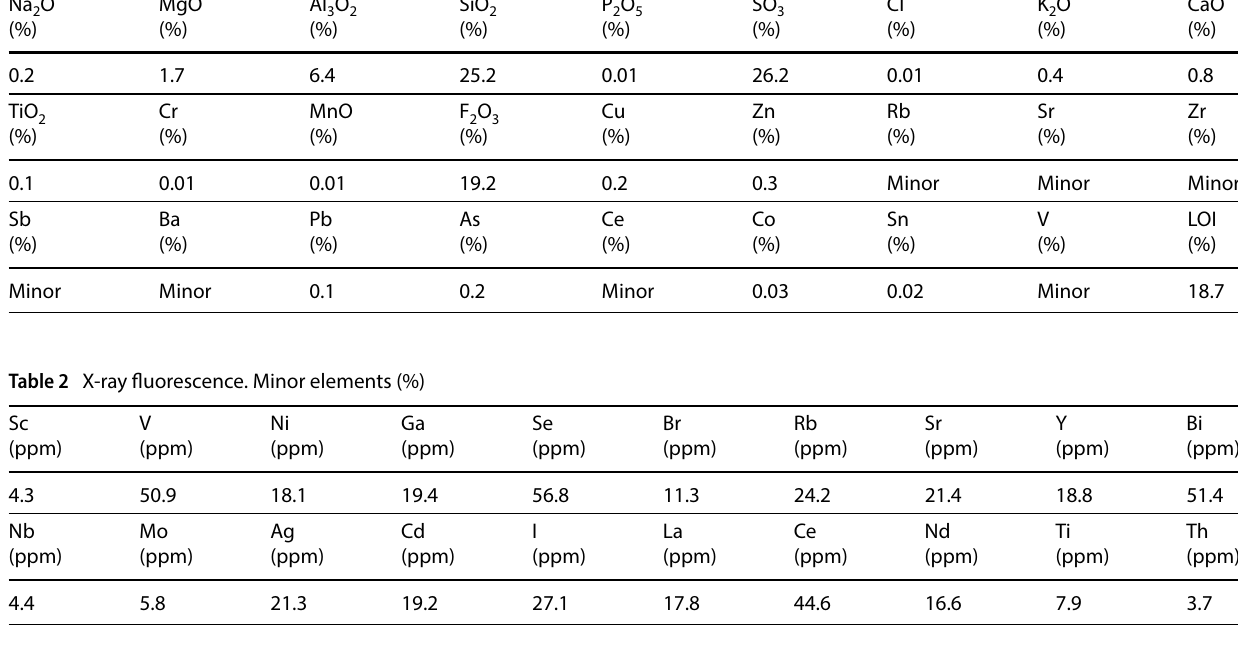
Fig. 2 Mine tailing X-ray dif- fraction [Q—quartz (SiO P-pyrite (FeS ); S—spinel 2 (CaAl O .10H O); C- anhydrite 2 4 2 (CaSO